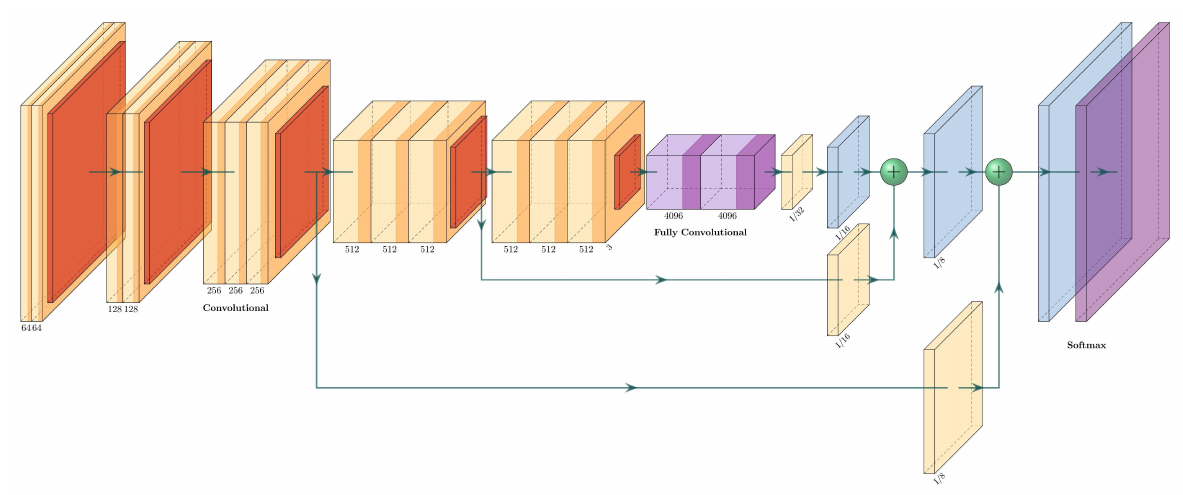
Figure 9. Architecture of the